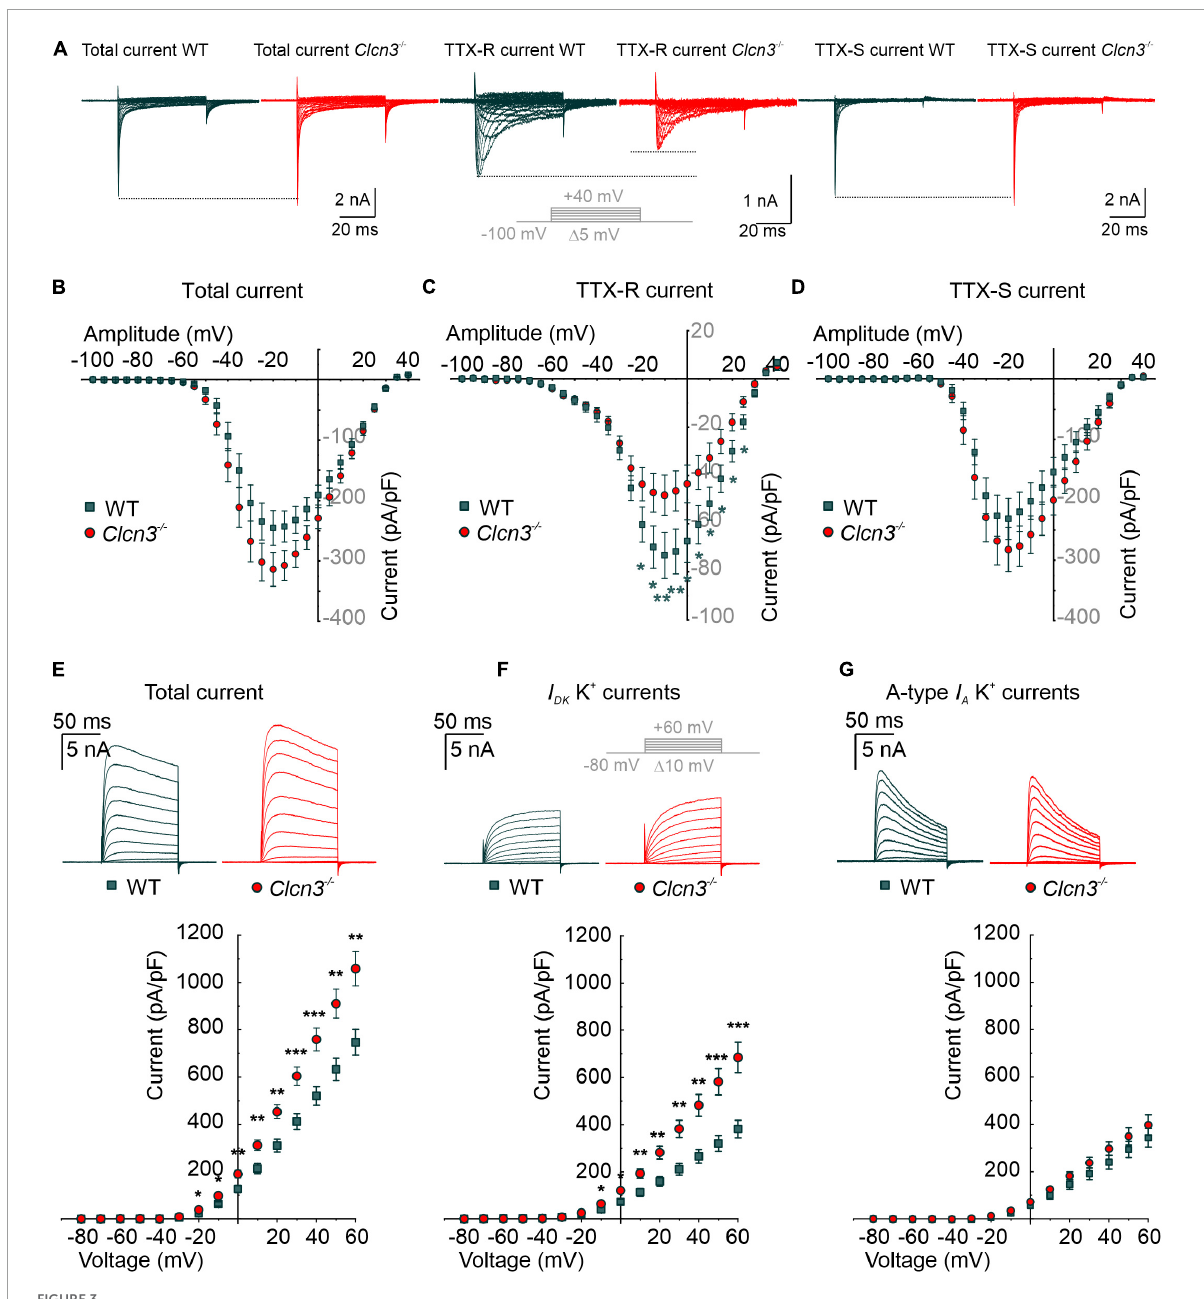
FIGURE3 Whole-cell Na + and K + currents from cultured wild type (WT) and Clcn3 − / − dorsal root ganglion (DRG) adult neurons. (A) Representative traces of Na + currents before (total Na + current) and during the application of 300 nM TTX (TTX-R current), and after digital subtraction of the TTX-R current from the total Na + current (TTX-S current) from WT (green) and Clcn3 − / − (red) cells. The inset illustrates the voltage protocol used to elicit Na + currents during and after TTX application. (B–D) Current–voltage relationships of total (B) , TTX-R (C) , and TTX-S (D) Na + current densities from WT (green, n = 23 from five animals) and Clcn3 − / − (red, n = 23 from eight animals) DRG neurons. Traces were aligned to the holding current at –100 mV, and dotted lines were set to the maximum pick current of the WT to illustrate changes in the Clcn3 − / − . (E–G) Representative recordings of the K + current (upper panel) and current–voltage relationship (lower panel) were obtained from WT (green, n = 16 from five animals) and Clcn3 − / − (red, n = 20 from three animals) DRG neurons. Inset in gray depicts the voltage protocol used to elicit K + currents during and after 4-AP application. (E) Total K + current densities are significantly higher in the absence of ClC-3. (F) Slow-inactivating K + currents obtained from the same neuron showed in E , after the application of 5 mM 4-AP, a compound that blocks fast-inactivating K + channels, showed a similar phenotype as for the total K + current. (G) Fast-inactivating K + currents are obtained by subtracting the slow-inactivating ( F ) from the total (E) current. Statistical significance levels are * p < 0.05, ** p < 0.01, and *** p < 0.001; Student’s t- test. Data are presented as mean ±